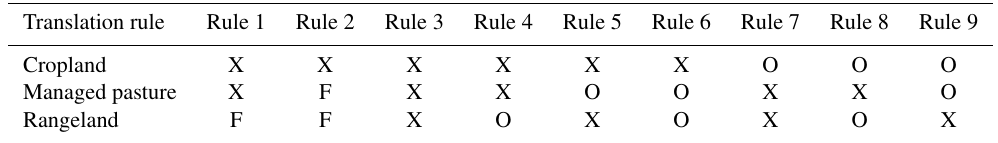
Table 1. Rules for vegetation clearance during cropland, pasture and rangeland expansion. “X” indicates complete removal of vegetation if the primary and secondary land state is altered. “O” indicates no vegetation removal when land-use change occurs. “F” indicates that vegetation is only removed if the preceding land cover is forested primary or forested secondary land. Translation rule Rule 1 Rule